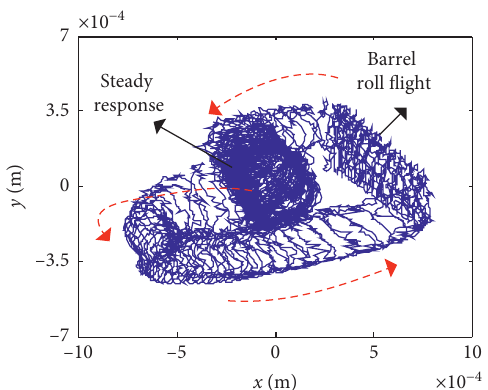
Figure 19: Transient axis orbit of the rotor test rig during the flight of the base motion platform ( t ∈ [ 0s , 6s ])